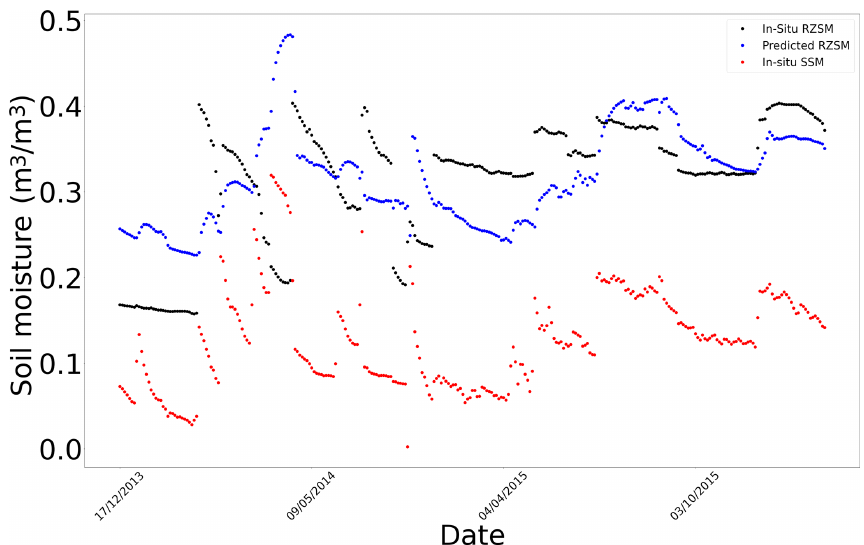
Figure F8. In situ SSM, in situ RZSM, and predicted RZSM series at station Widgiewa with model ANN_SSM_NDVI_EVAP-EFF-